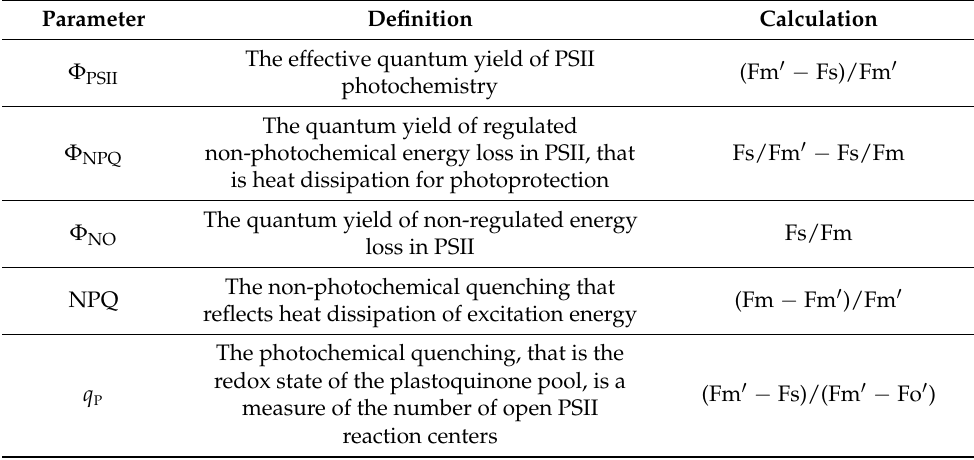
(Fm (cid:48) − Fs)/Fm (cid:48) Fs/Fm (cid:48) − Fs/Fm Fs/Fm (Fm − Fm (cid:48) )/Fm (cid:48)